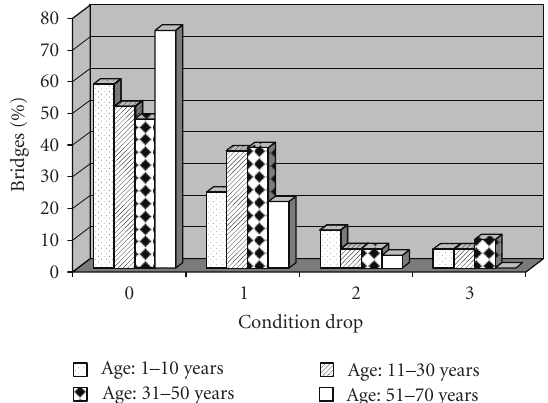
Figure 3: Trend of bridges deck condition deterioration by bridge age